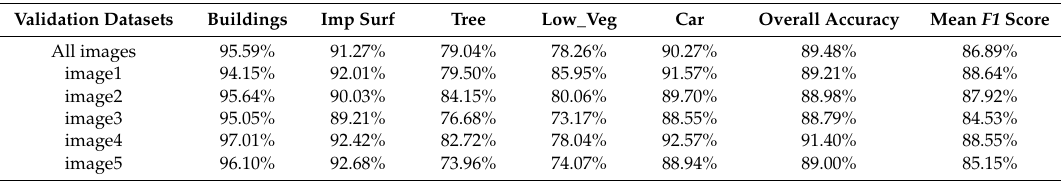
Table 1. The average overall accuracy ( OA ) and mean F1 score on all the validation datasets and individual datasets.